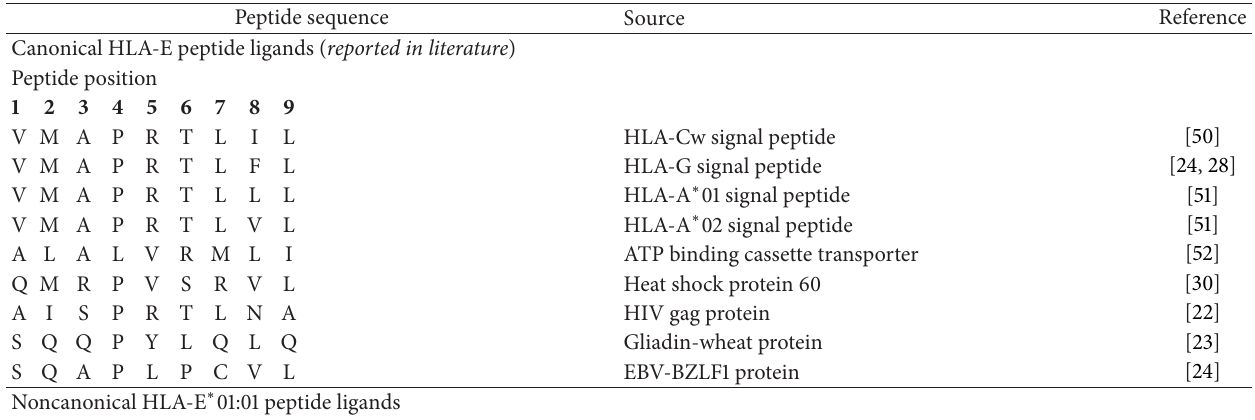
Table 1: Canonical and noncanonical HLA-E peptide